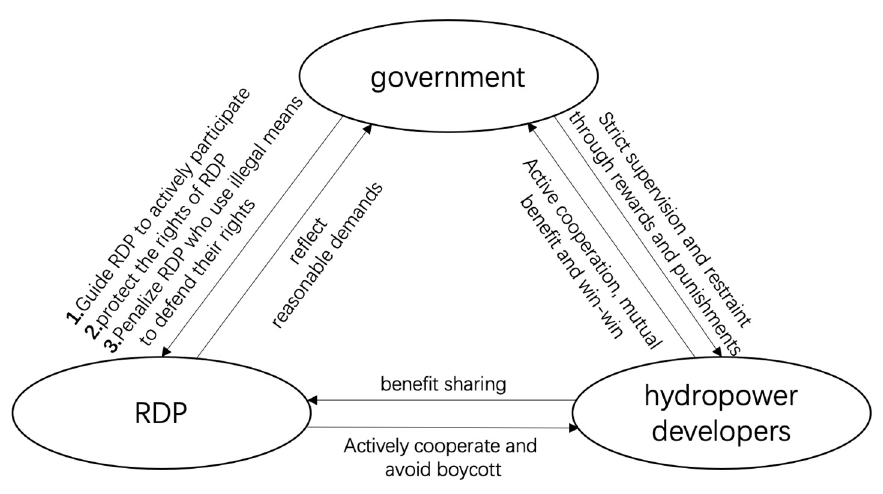
Figure 11. Related